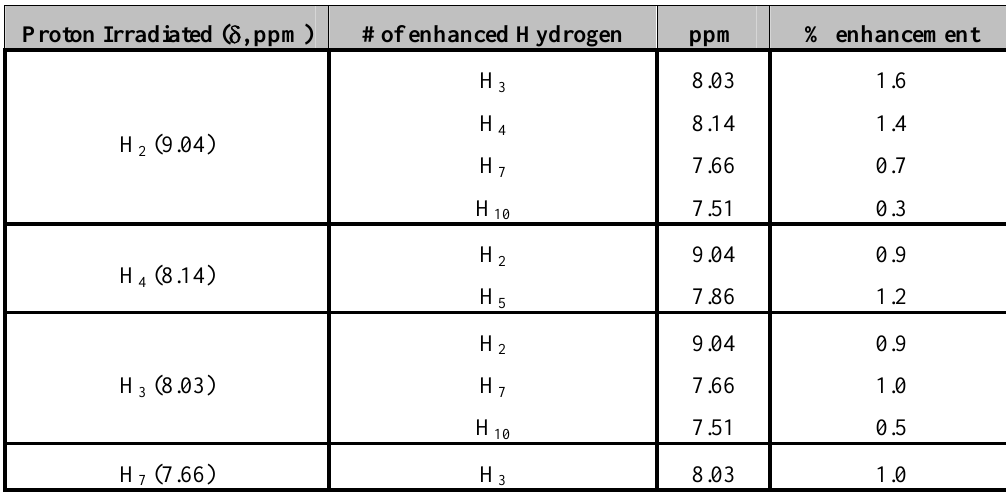
Table 2. 1 H-NMR Nuclear Overhauser Effect experimental data.